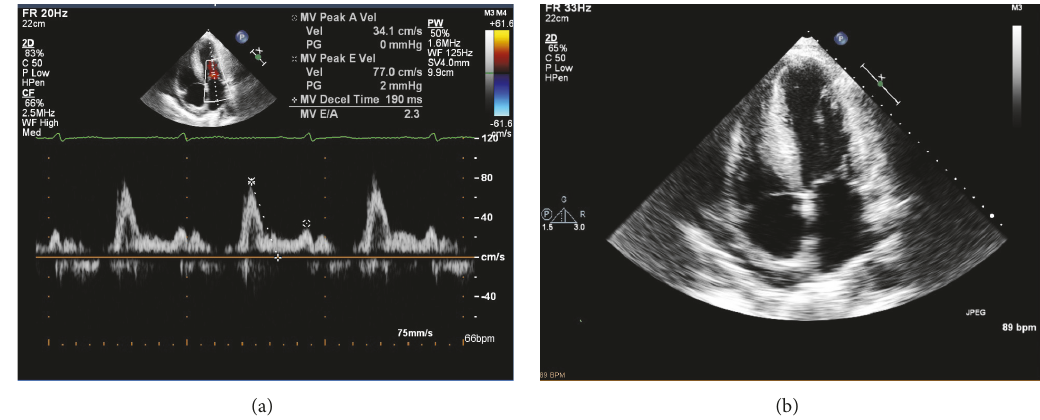
Figure 1: (a) At baseline, the transthoracic echocardiogram demonstrates moderately depressed LV function (LVEF-40%) with significant concentric and septal LV hypertrophy (LV mass 367 grams, IVSd-2.1 cm, PWT-1.5cm, RWT-0.67). (b) There is further evidence of elevated filling pressures. There is left atrial enlargement (LA dimension-4.6 cm), mildly elevated estimated right ventricular systolic pressure (RVSP ∼ 36 mmHg), and restrictive filling on mitral inflow Doppler (E/A-2.3, deceleration time 190 milliseconds).